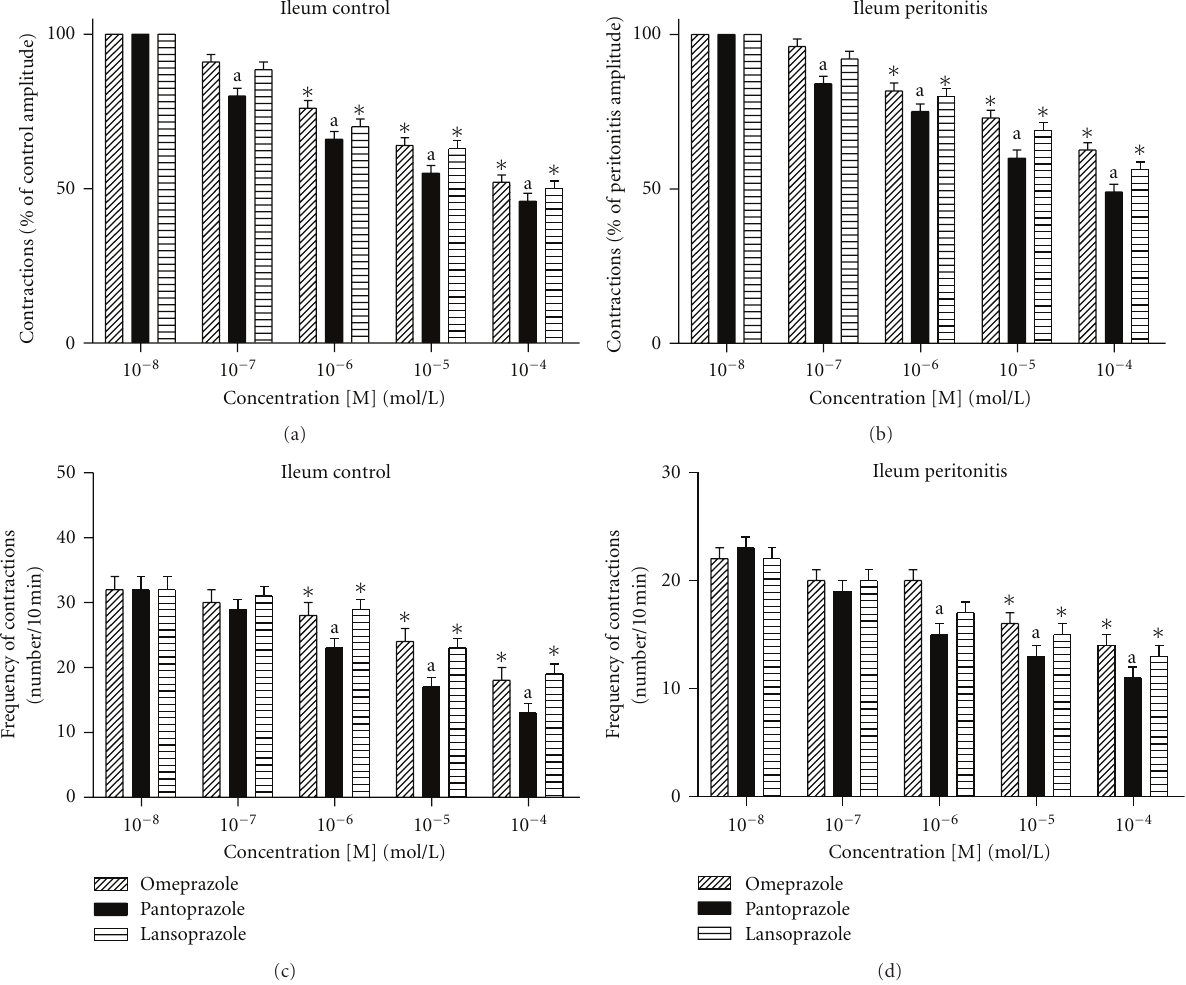
Figure 2: Amplitudes of the contractions induced by omeprazole, pantoprazole, and lansoprazole. (a) Control group; (b) peritonitis group; both were calculated as the percentage of the initial contractions. ( ∗ P < 0 . 05 versus initial contractions, a P < 0 . 05 versus omeprazole and lansoprazole; analysis of variance followed by Tukey test.) Changes induced by omeprazole, pantoprazole, and lansoprazole in the frequency of spontaneous contractions. (c) Control group; (d) peritonitis group. Both were expressed as the number of contractions for 10 min. ( ∗ P < 0 . 05 versus initial contractions, a P < 0 . 05 versus omeprazole and lansoprazole; analysis of variance followed by Tukey test.)